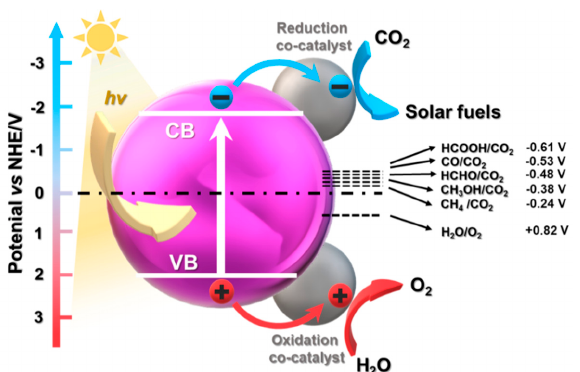
Figure 10. Scheme representing photocatalytic CO 2 reduction process.